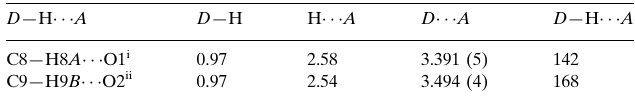
Hydrogen-bond geometry (A˚ , (cid:3)